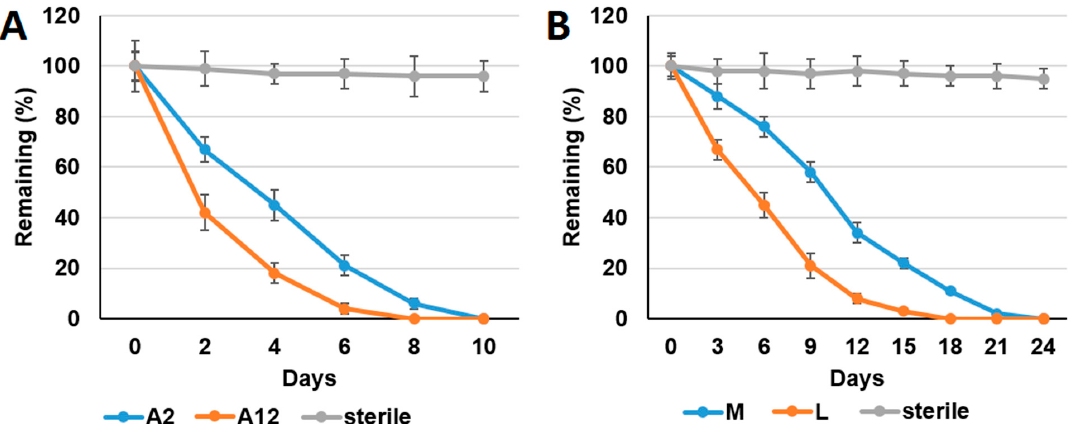
Figure 4. Biodegradation of sulfamethoxazole (SMX) by the four isolated bacterial strains (A2, A12, L, and M) without fish pond sediments. ( A ) Aerobic SMX biodegradation by strains A2 and A12. ( B ) Anaerobic SMX biodegradation by strains L and M. Data from three independent experiments are presented as the mean ± SE.